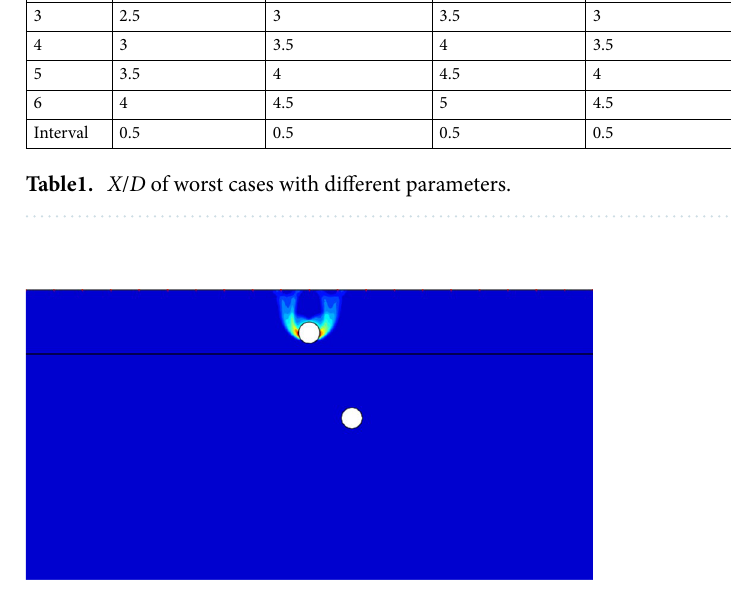
Figure 11. The UB failure mechanism of c u1 / c u2 = 0.5, X / D = 2, Y / D = 4.